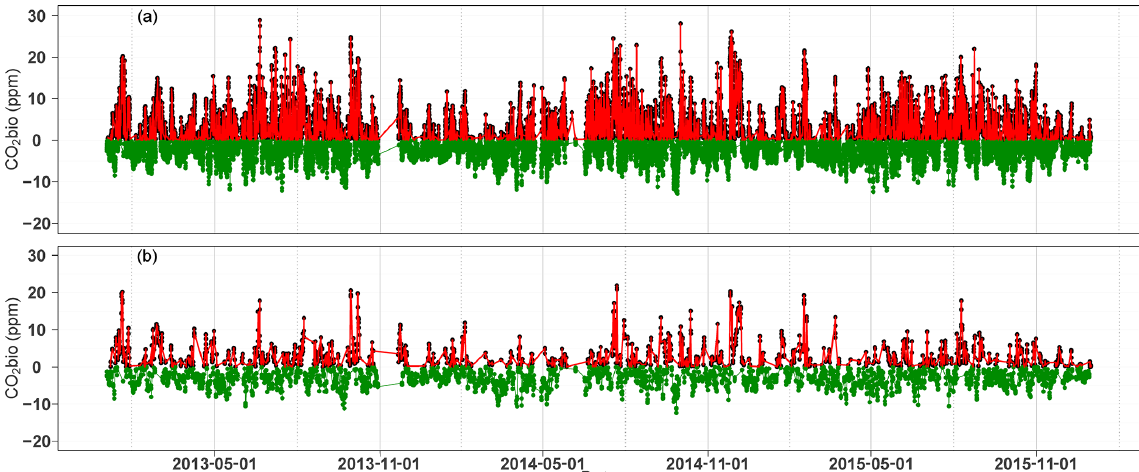
Figure 5. Time series (hourly resolution) of the biospheric CO 2 derived as a residual of the difference between the total CO 2 , CO 2bg , and CO 2ff for all data (a) , and only afternoon data from 12:00–15:00UTC (b) . The green lines show negative CO 2bio , implying uptake, while red ones represent positive CO 2bio . The average uncertainty of CO 2bio amounts ± 1.3ppm calculated from error propagation.